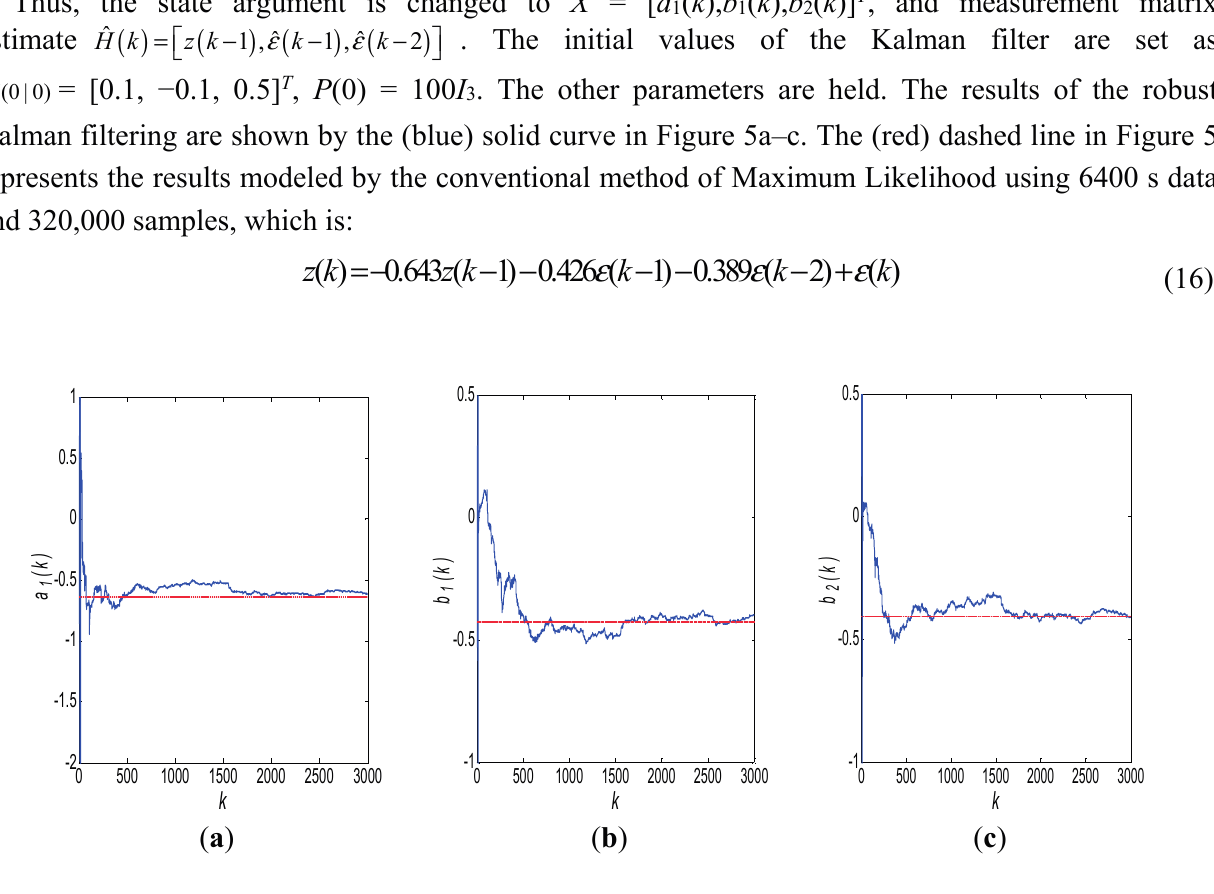
Figure 5. ARMA (1,2) modeling results using a robust Kalman filter: ( a ) a 1 estimate, ( b ) b 1 estimate, and ( c ) b 2